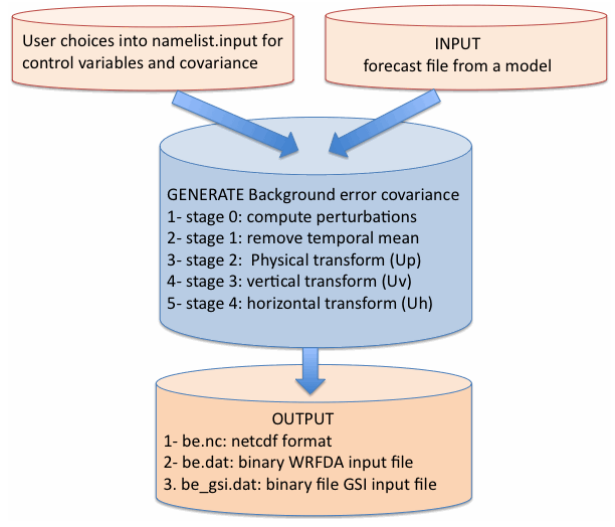
Figure 1. General structure of the code to generate a background error covariance matrix. The input and output are represented by the orange boxes and the five main stages that lead to model B are in